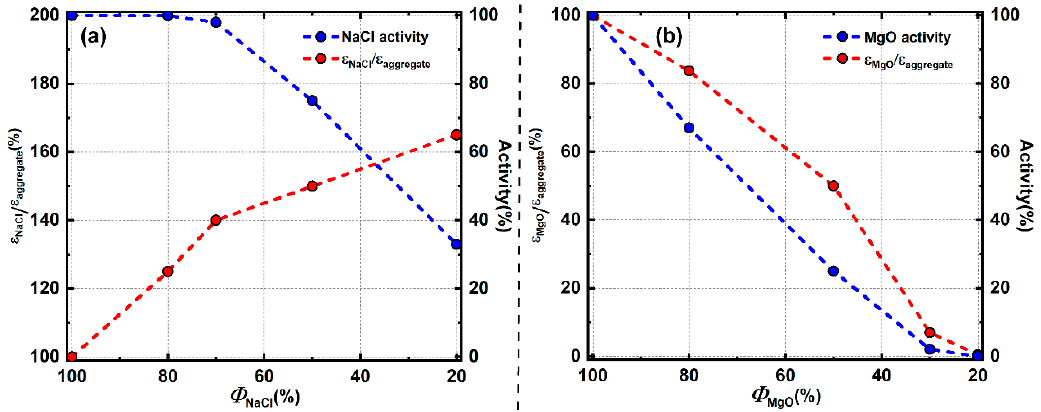
Figure 15. Activity and average strain evolution with phase proportion; ( a ) NaCl; ( b ) MgO.